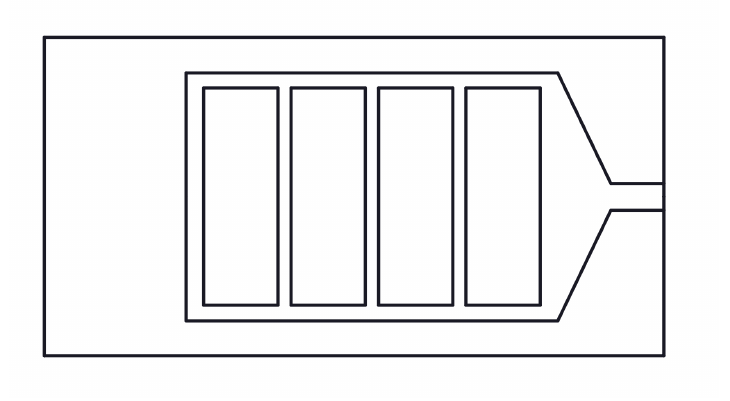
Figure 26. Rectangular slot—best geometry.